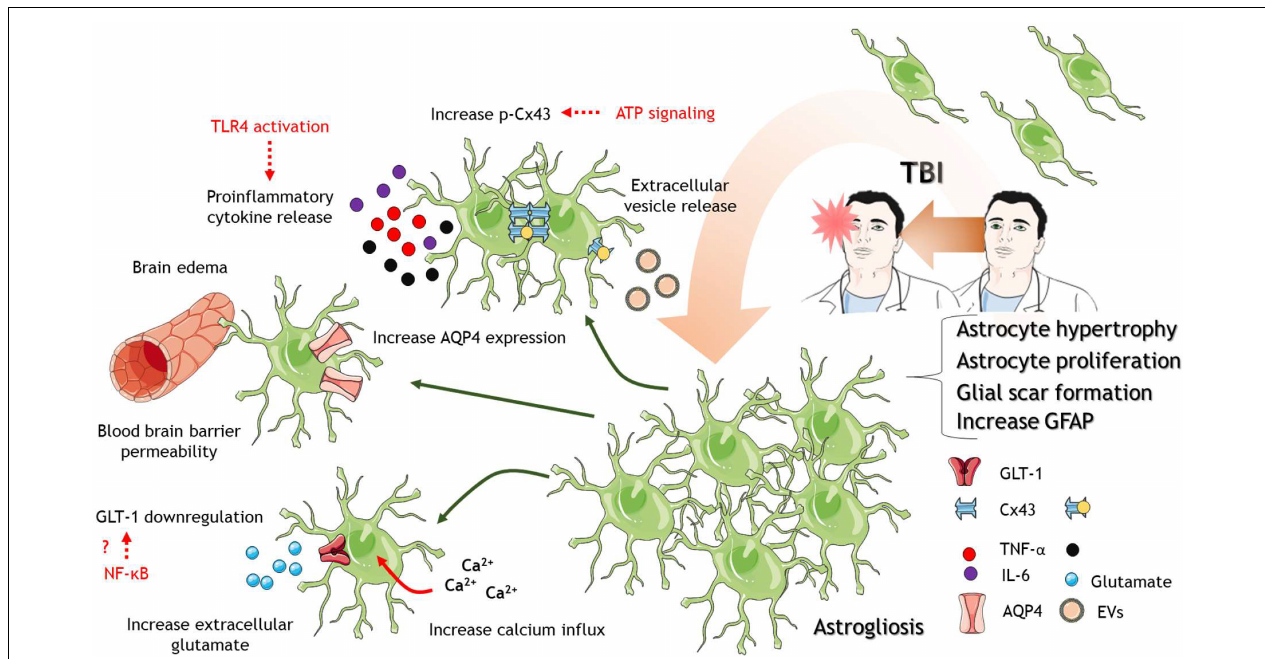
FIGURE 1 | Astrocytes in response to TBI. After TBI of different severities, astrocytes are activated where they proliferate and increase in size. Astrocyte proliferation and activation lead to the formation of a protective glial scar. Several mechanisms at the molecular level accompanied astrocytic activation. Between them, increase calcium influx into astrocytes, downregulation of glutamate transporter GLT-1, the release of proinflammatory cytokines and TLR4 activation, increase p-Cx43 levels, increase AQP expression, and disruption of the blood-brain barrier that contributes to brain edema. The cartoon was made using SERVIER Medical Art templates